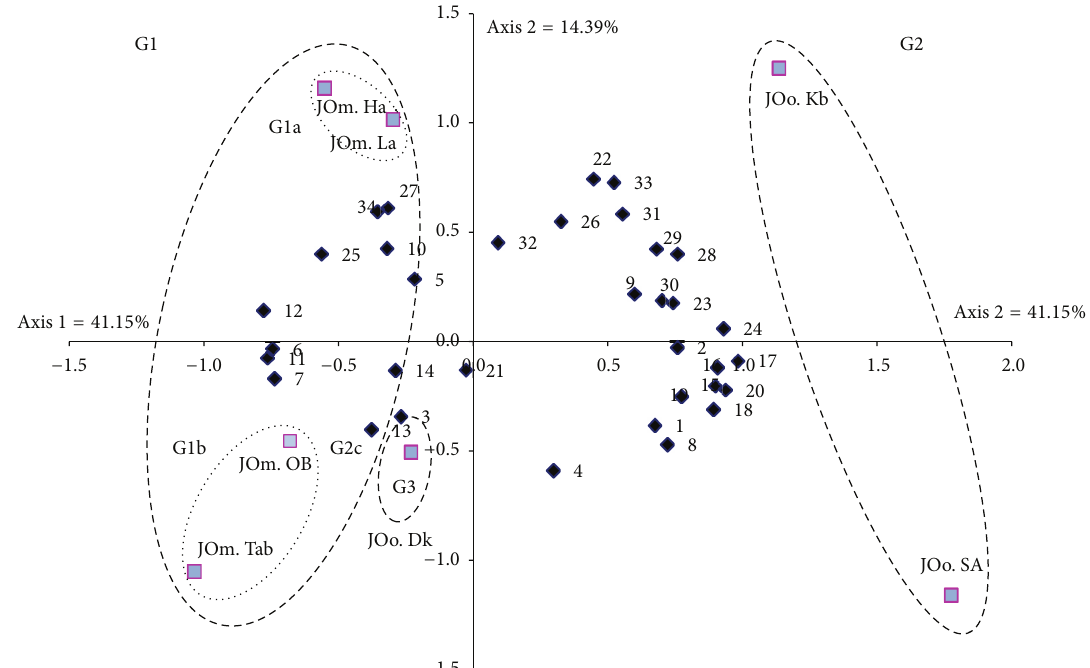
Figure 1: PCA of the 34 major components of the leaf essential oils of J. oxycedrus ssp. oxycedrus and J. oxycedrus ssp. macrocarpa . JOm: J. oxycedrus ssp. macrocarpa, J.Oo: J. oxycedrus ssp. oxycedrus , Dk: Dkhila, OB: Oued El Bir, Tab: Tabarka, SA: Sidi Ameur, Ha: